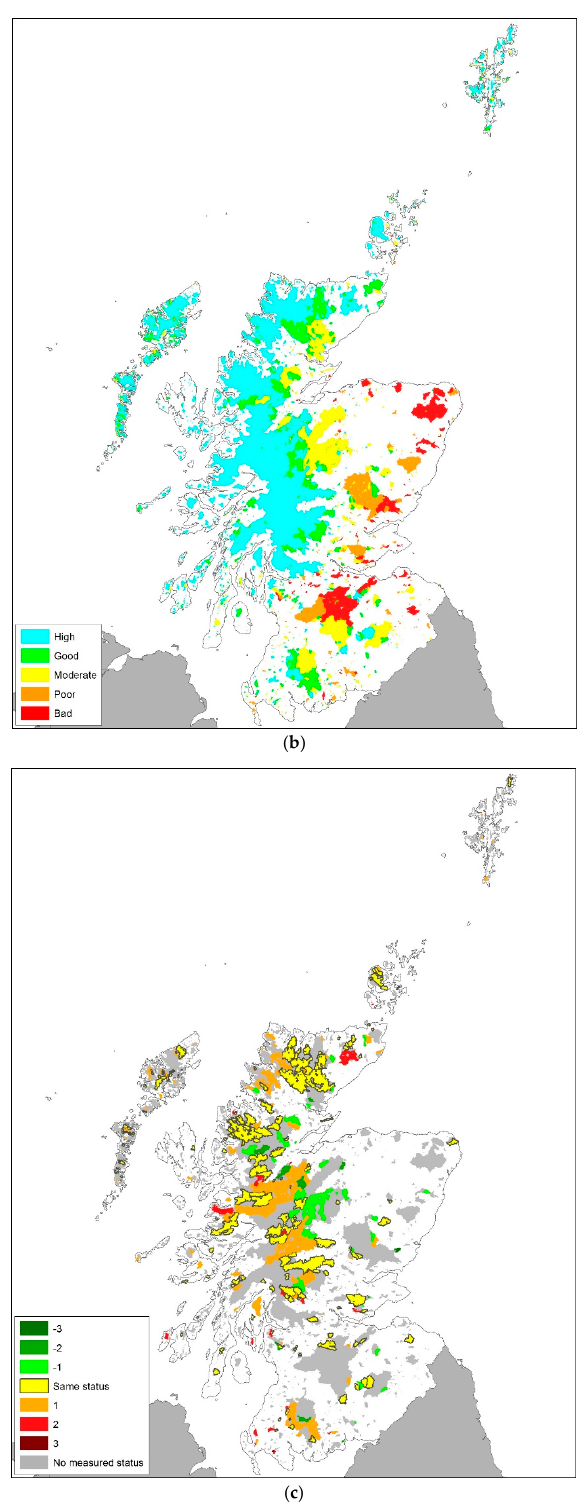
Figure 7. ( a ) WFD water body status based on 323 standing waters monitored by SEPA. Un-monitored catchments are shown in dark grey (No data). ( b ) WFD water body status based on modelled TP at 7794 standing waters (not all water bodies in the database have WFD thresholds that allow status assessment). ( c ) Difference between modelled status and measured status as described in Section 3.3.3 (e.g., 0 (yellow) = same modelled and measured water body class; − 1 (light green) modelled = Good and measured = High (Table 4).